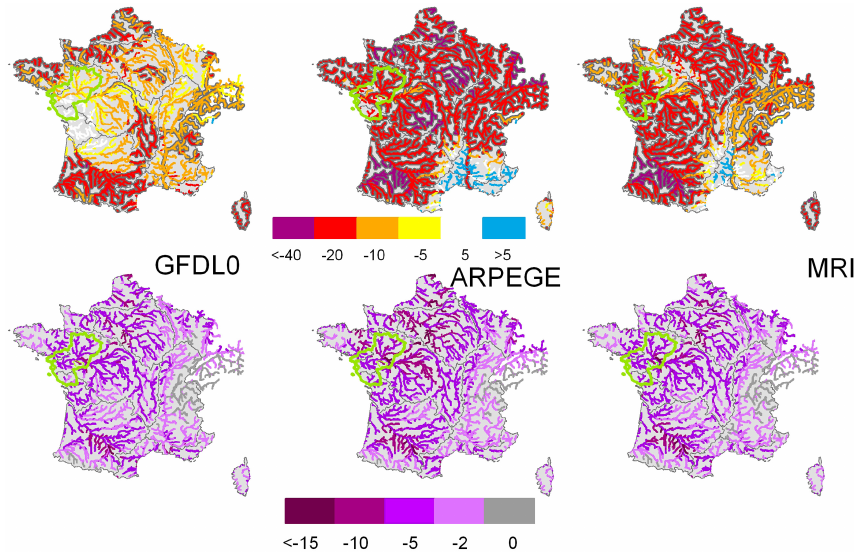
Figure 16. Impact of climate change (top) and small farm dams (bottom) on the annual discharge in 2050 as projected using three downscaled climate projections (in %). Small farm dams are assumed to cover 0.5% of the area, with a catchment that covers half the basins, and the filling period is taken as 5 months. Top, changes that are significant at the 95% level are outlined in black. Bottom, the distinction is not made because only a few river cells gave results significant at the 95%